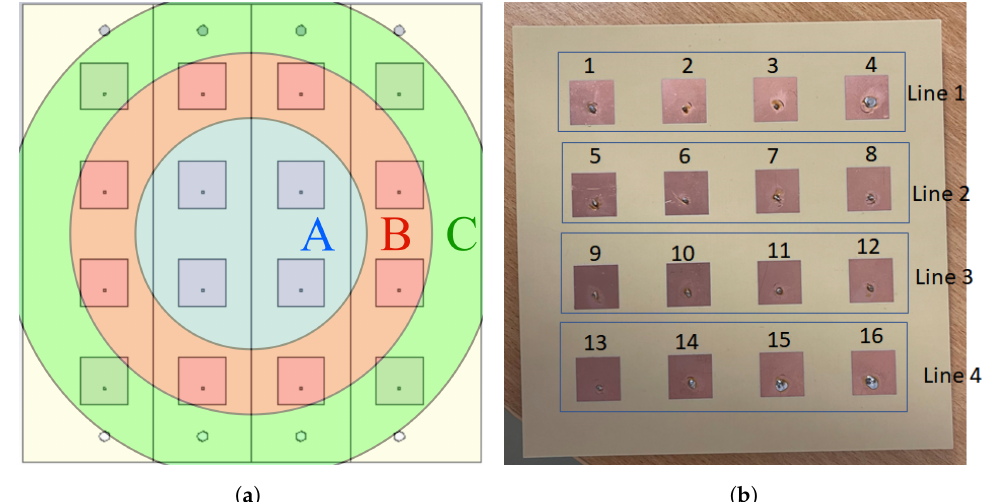
Figure 8. ( a ) Design of the phased array antenna in the CST Studio Suite, where the patch separation into groups is visible. ( b ) Picture of the printed antenna, with the connectors soldered in place. Beamforming was achieved by grouping the elements as described in Table 1 and applying phase differences, which enable the results summarized in Table